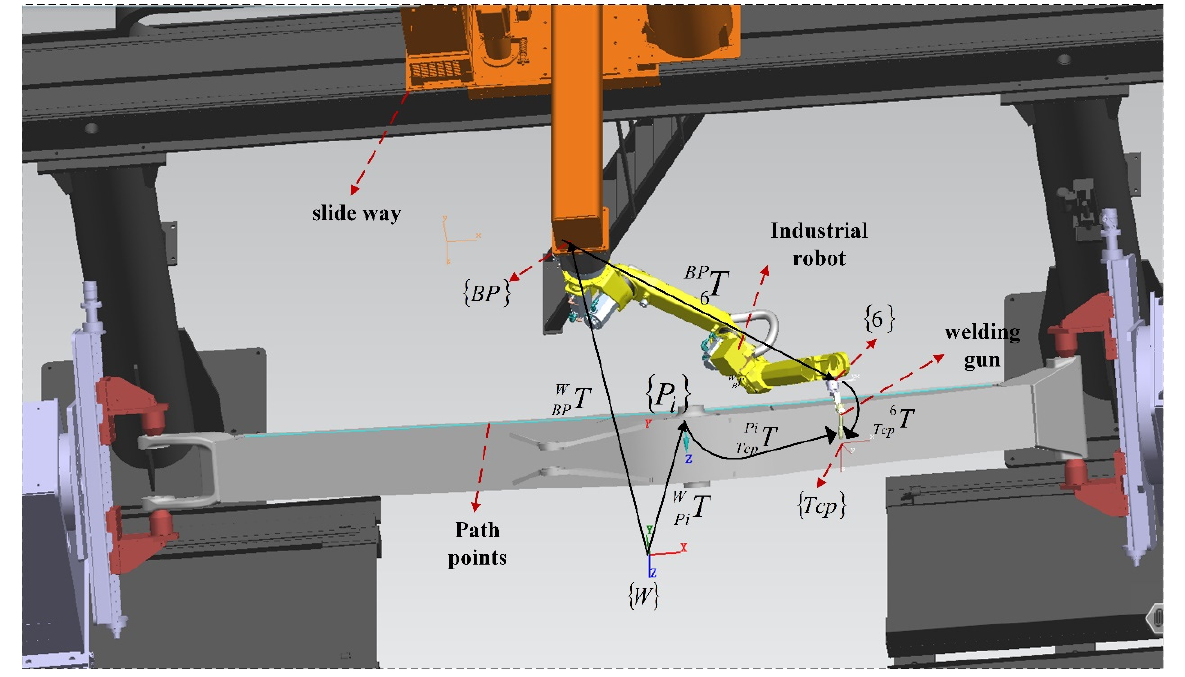
Figure 10. Welding system -related coordinate system.